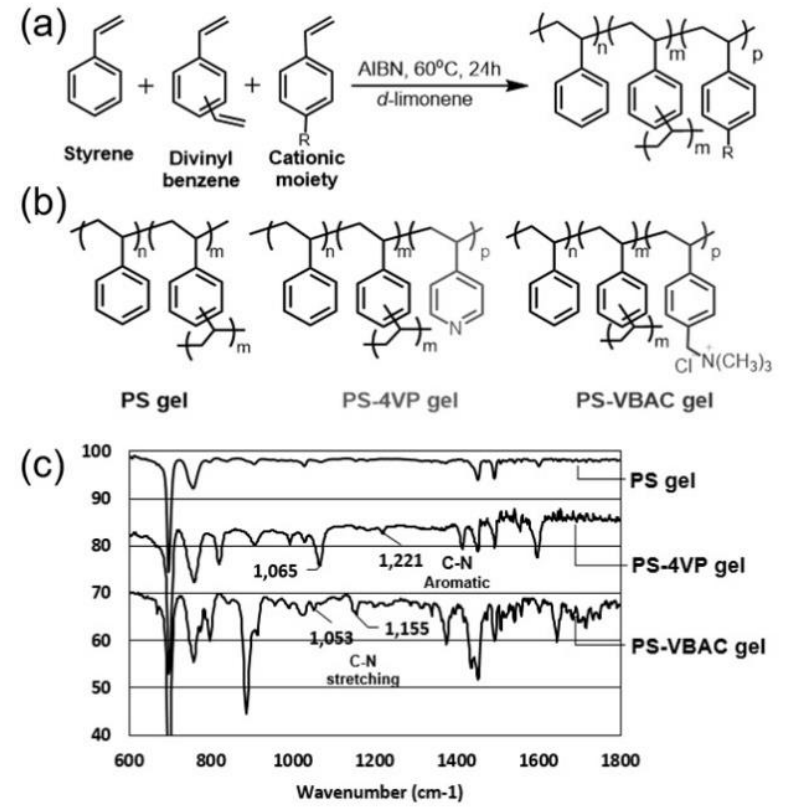
Figure 1. ( a ) Preparation of cross-linked PS gel in d-limonene. ( b ) Chemical structure of cross-linked PS gels. ( c ) FT-IR spectra of dry PS gel, PS-4VP gel and